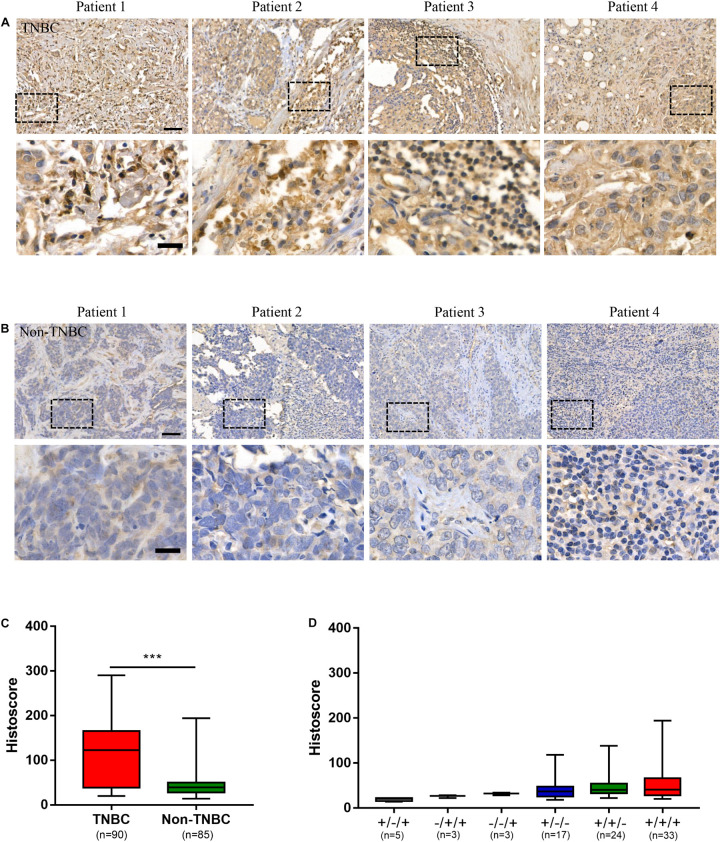
ICAM1 was upregulated in triple negative breast cancer (TNBC) tissues. (A,B) Microarrays of human TNBC tumors and non-TNBC tumors were stained with an anti-human ICAM1 antibody for IHC to detect the expression of ICAM1. Scale bars indicated 50 μm (top) and 20 μm (bottom). (C,D) ICAM1 staining intensities in different subtypes of non-TNBC (status of ER/PR/HER2: ±/+; −/+/+; −/−/+; ±/−; +/±; +/+/+) and TNBC tissues. Data are presented as a box-and-whisker plot. ***p < 0.001.